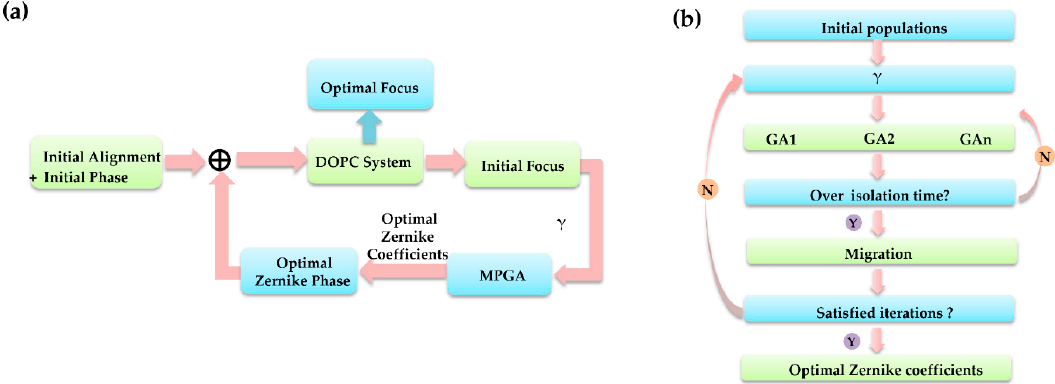
Figure 1. Schematic illustration of the automatic optimized method for a digital optical phase conjugation (DOPC) system. ( a ) Flow chart of the automatic optimized method for a DOPC system based on a multipopulation genetic algorithm (MPGA). ( b ) Flow chart of MPGA.